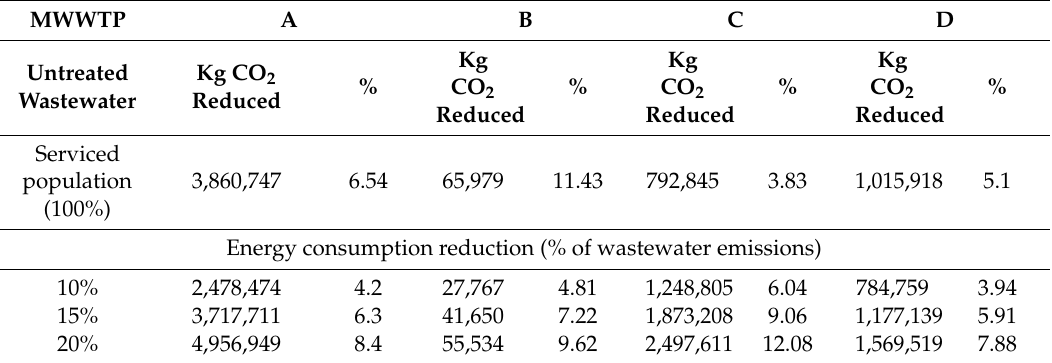
Table 6. Evaluation of GHG reduction considering di ff erent scenarios: increase in serviced population and reduction of energy